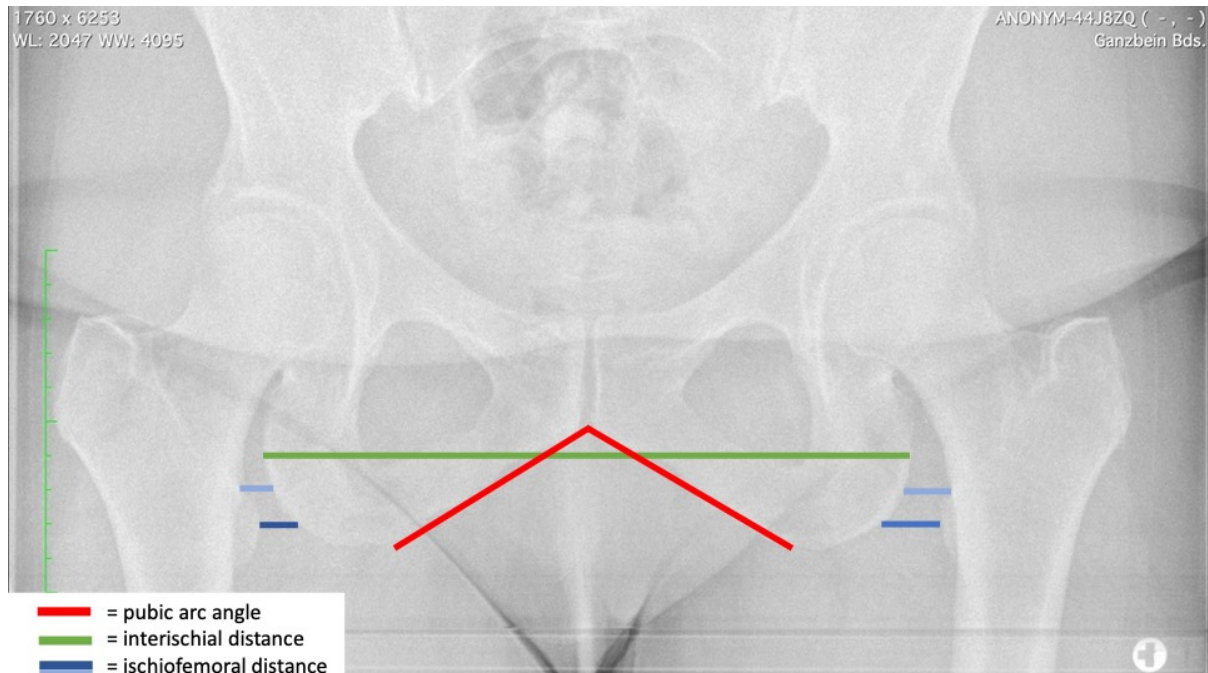
Figure 1. Illustration of the morphometric parameters. The red line represents the pubic-arc angle (also known as the subpubic angle). The green line represents the interischial space, defined as the distance between the lateral borders of both ischii. The blue lines (dark and light) represent the two lines used to measure the ischiofemoral distance.